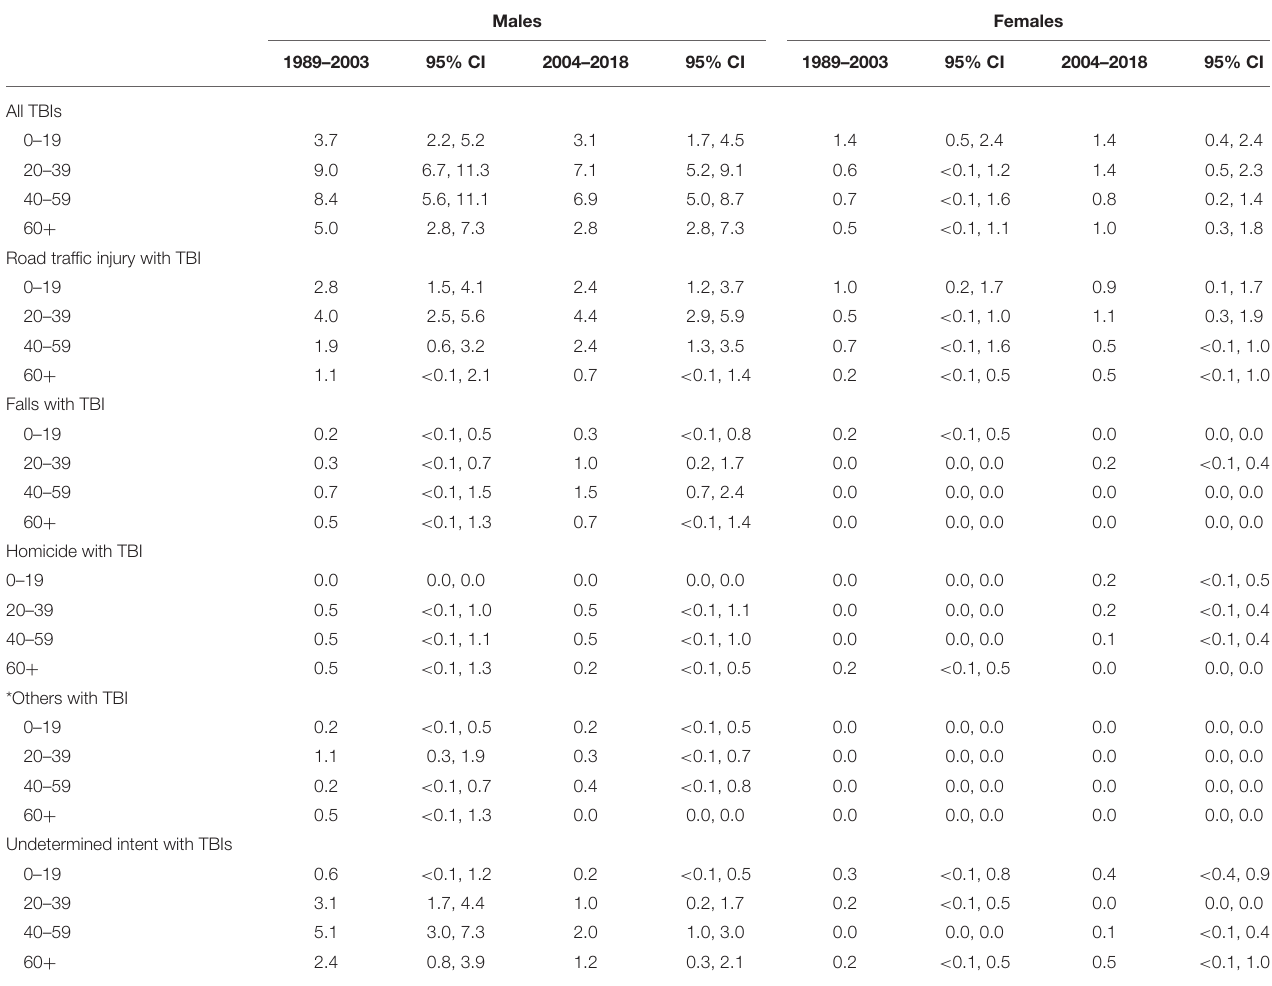
TABLE 3 | Age-standardised TBI-related mortality rates according to period, sex and age.